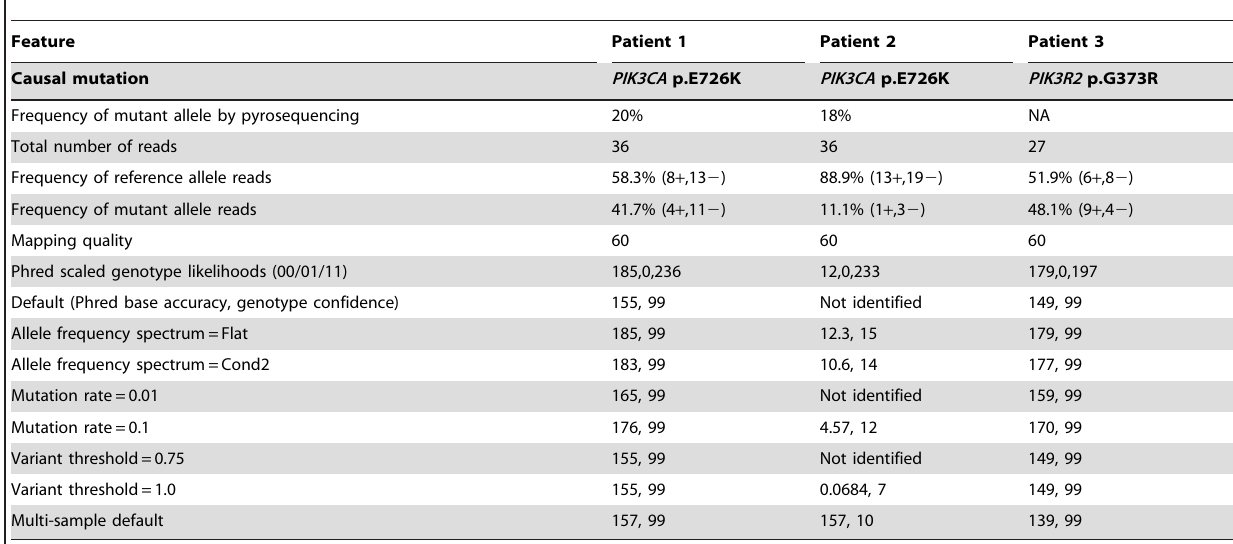
Table 2. Characteristics of causal variants in PIK3CA and